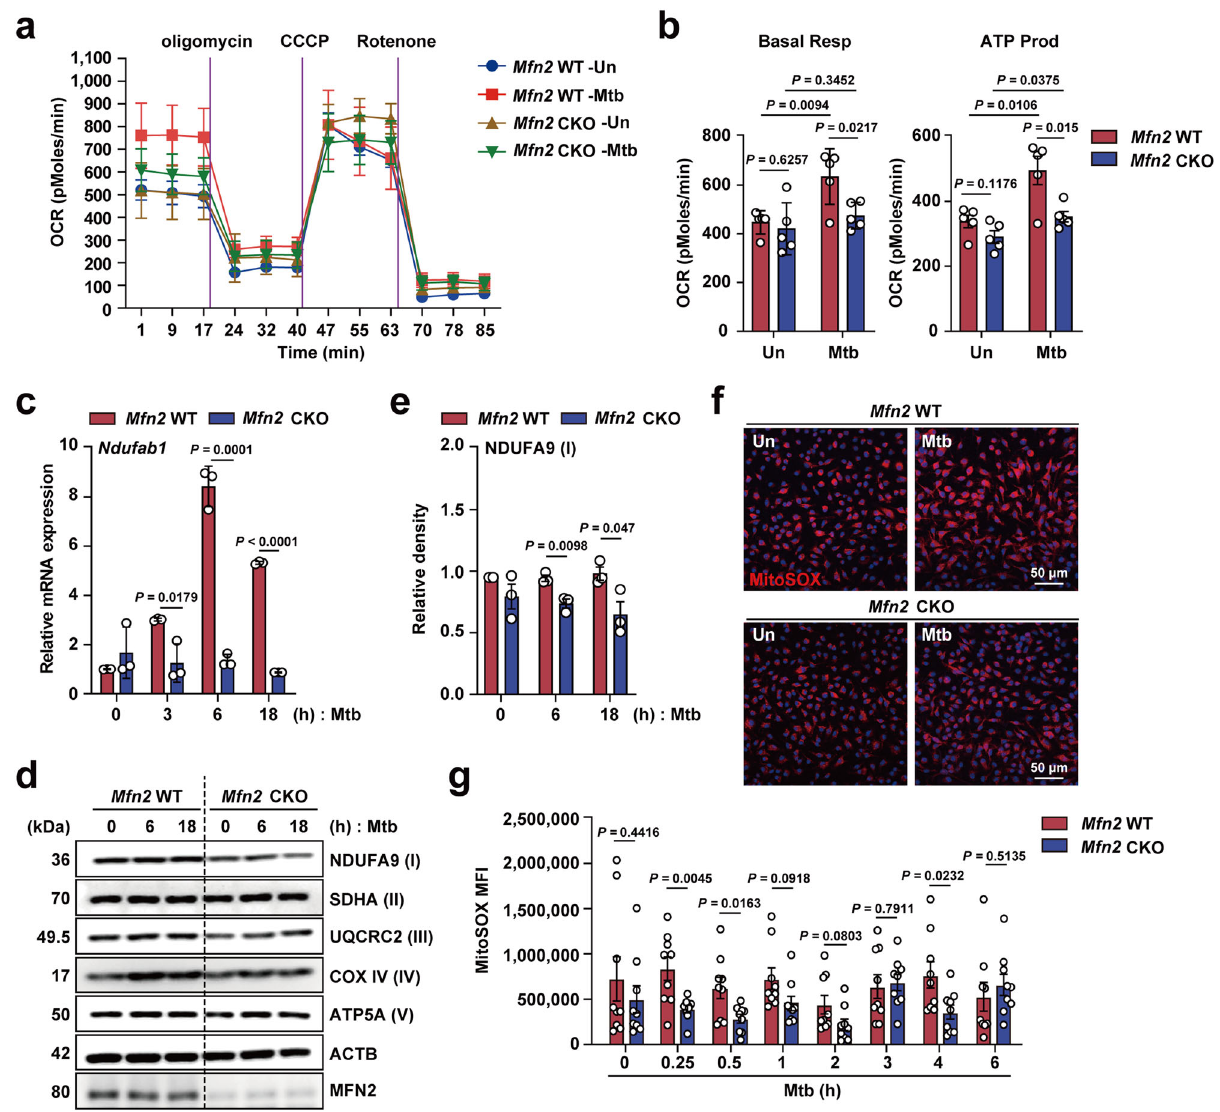
Fig. 4 MFN2 is required for basal mitochondrial respiration and mtROS production during bacterial infection. a , b Respiratory pro fi le (OCR) ( a ) and their respiratory parameters; Basal respiration (Basal resp) and ATP production OCR (ATP prod) ( b ) in Mfn2 WT and Mfn2 CKO PMs infected with Mtb (MOI 5) for 18 h. c qPCR analysis of Ndufab1 in Mfn2 WT and Mfn2 CKO PMs infected with Mtb (MOI 5) for indicated time ( n = 3). d Western blot analysis of OXPHOS complexes in Mfn2 WT and Mfn2 CKO BMDMs infected with Mtb (MOI 5) as indicated. e Densitometry analysis of NDUFA9 western blot represented in ( d ) ( n = 3). f Representative MitoSOX (red) or DAPI (for nuclei; blue)-stained images. BMDMs from Mfn2 WT or Mfn2 CKO mice were infected with Mtb (MOI 5 for 4 h) and visualized by confocal microscopy. Scale bars, 50 μ m. g Average mean fl uorescence intensities (MFI) of MitoSOX. Data are presented as mean ± SD ( c ) or mean ± SEM ( b , e , g ) and are representative of three independent experiments. Two-tailed Student ’ s t test is used to calculate the signi fi cance ( b , c , e , g ). Un,